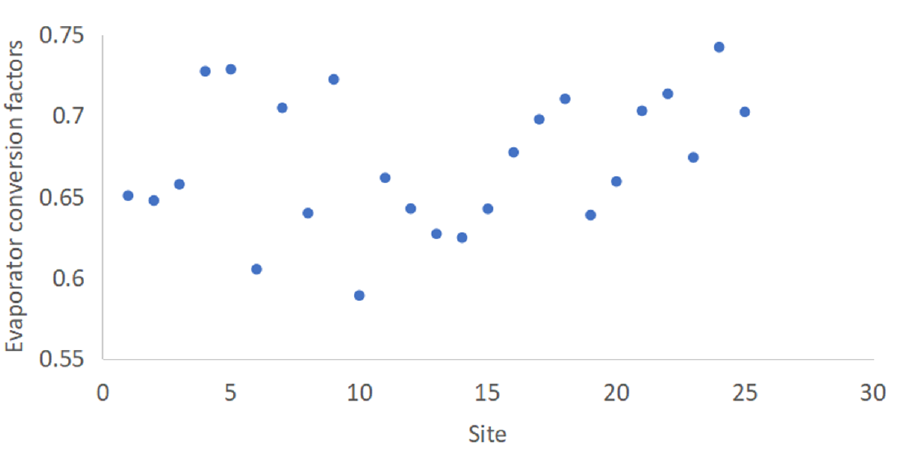
Figure 9. Conversion coefficients for two evaporation pans for the first cycle (series length of 23 years). The conversion coefficient is the observed value of E601 pan/D20 pan, and the formula used was Formula